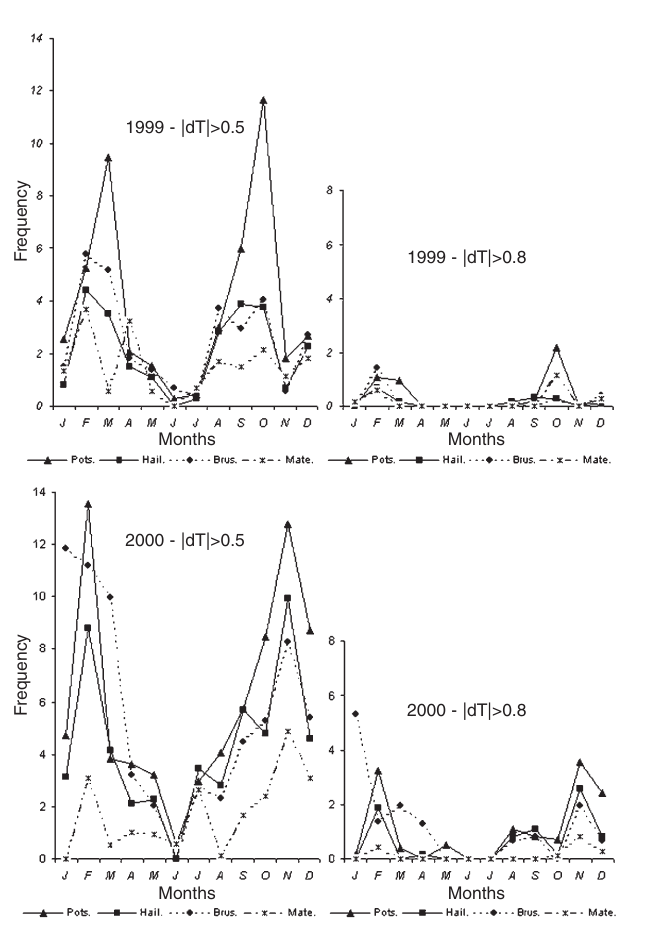
Fig. 7. Probabilities that the levels 0.50 or 0.80 of the relative deviations (in absolute value) of TEC are exceed- ed during 1999 and 2000 at four European